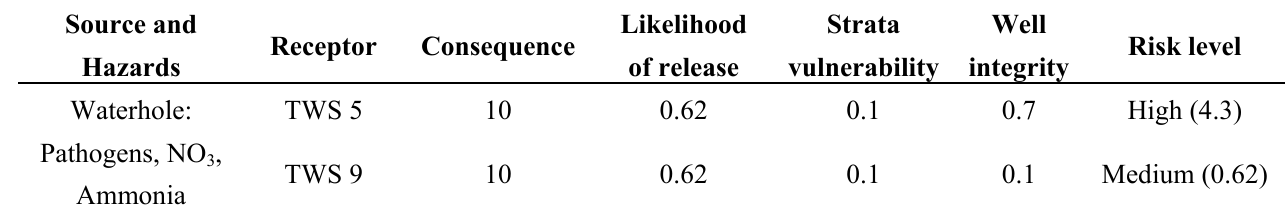
Table 9. Summary of risk assessments for TWS 5 and TWS